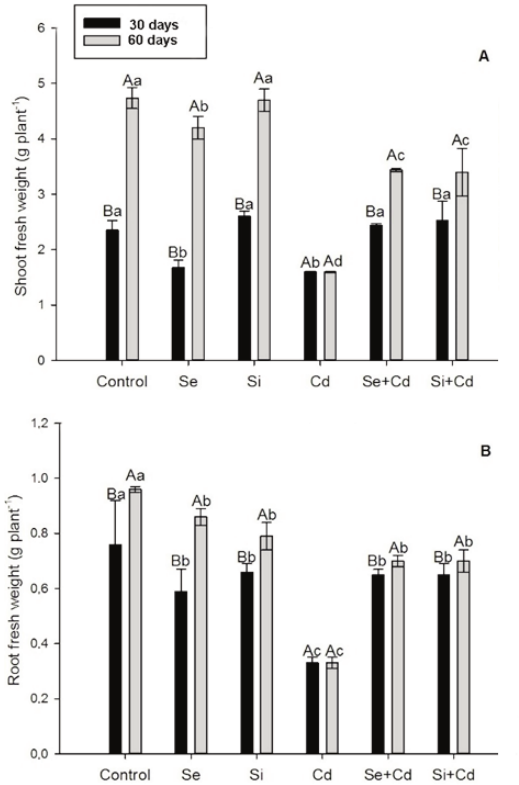
Fig. 1 - Effect of selenium (2.5 μM) or silicon (2.5 mM) on shoot (A) and roots fresh weight (B) of potato plants grown in presence of cadmium (50 μM) at 30 and 60 days after application of the treatments. Different lowercase letters indicate significant differences between treatments in same collect. Different uppercase letters indicate signifi- cant differences between collects for same